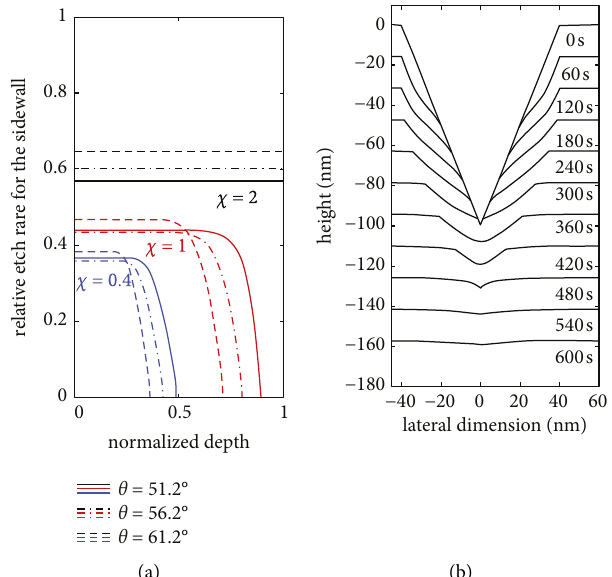
Figure 9: (a): Sidewall etch rate relative to the planar top surface etch rate. (b): Temporal evolution of the cross-section profile of a pit with h � 100nm and χ � 0.4 [56].